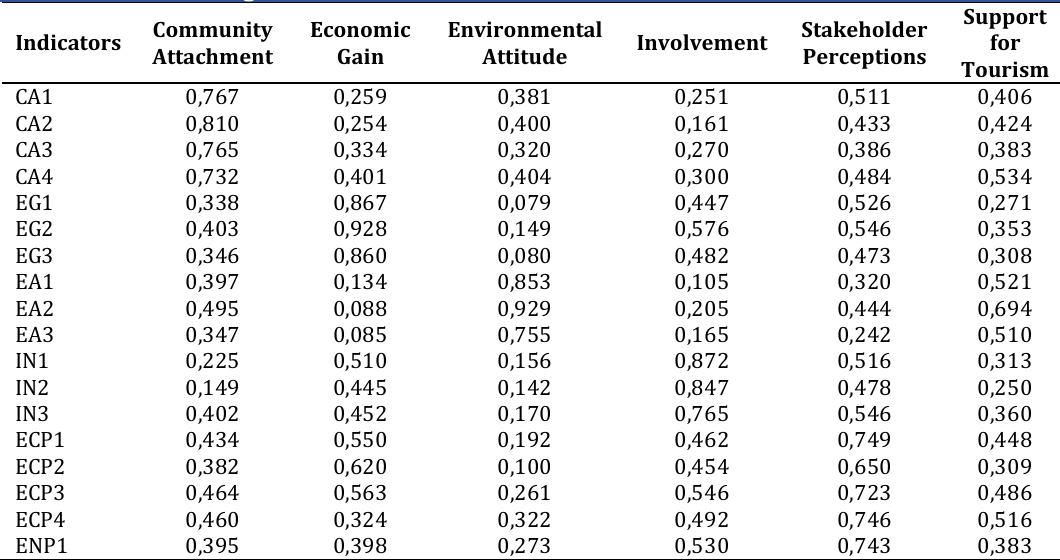
Table 5: Cross loading